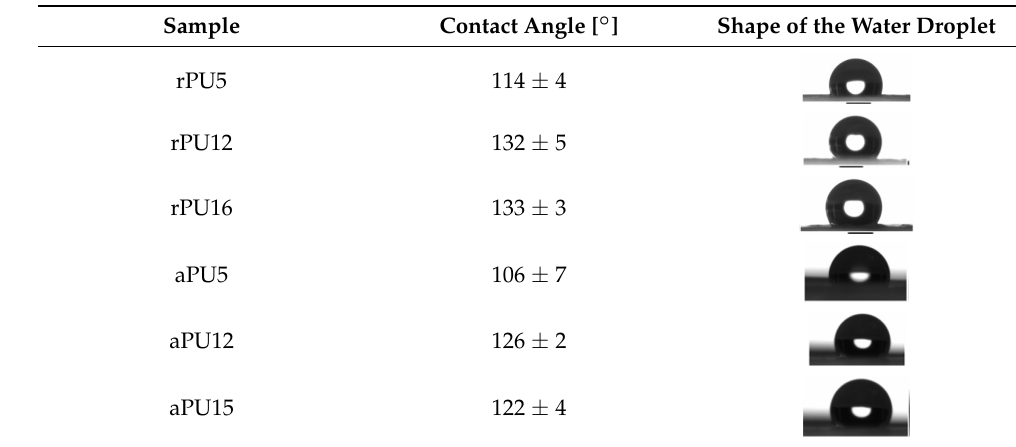
Table 4. The hydrophilicity of the tested samples.